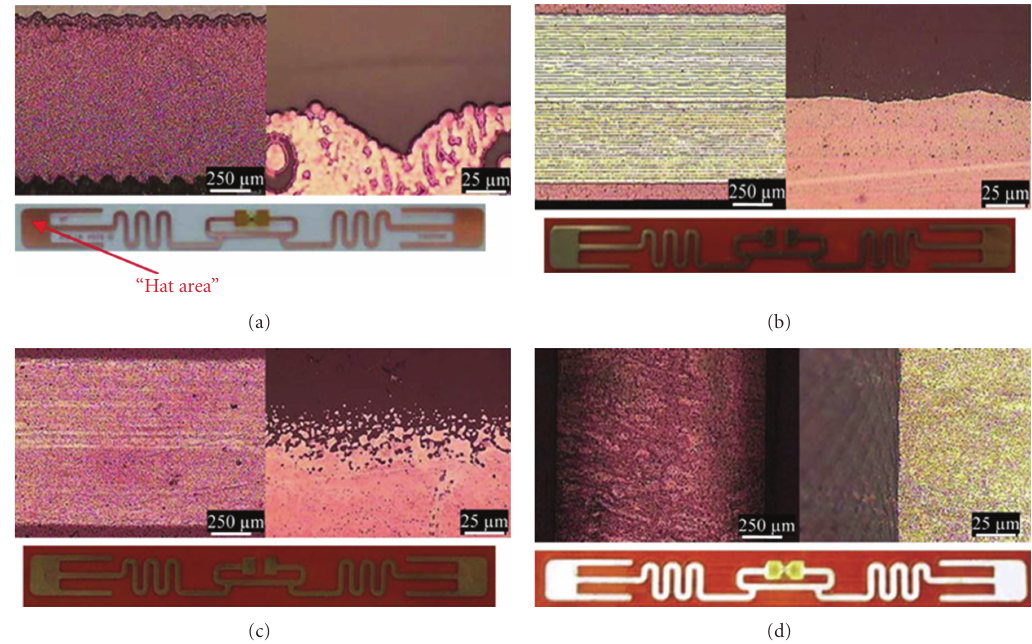
Figure 19: Picture and micrographs of alien squiggle antennas made with (a) copper etching, (b) CAB-DW, (c) Aerosol Jet, and (d) MAPLE- DW, reprinted from Hoey et al. [95], Copyright 2009 IEEE.